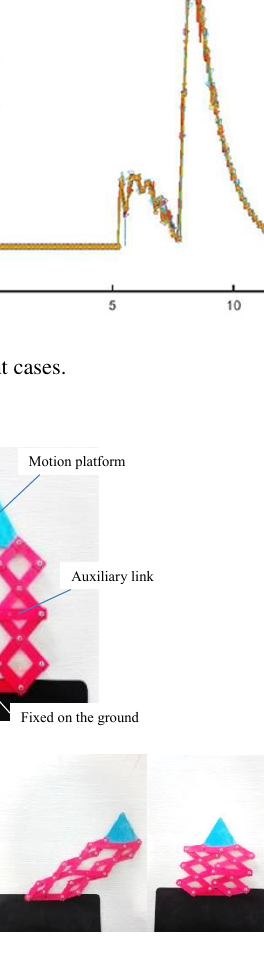
Figure 31. Prototype of one SLE-Pa